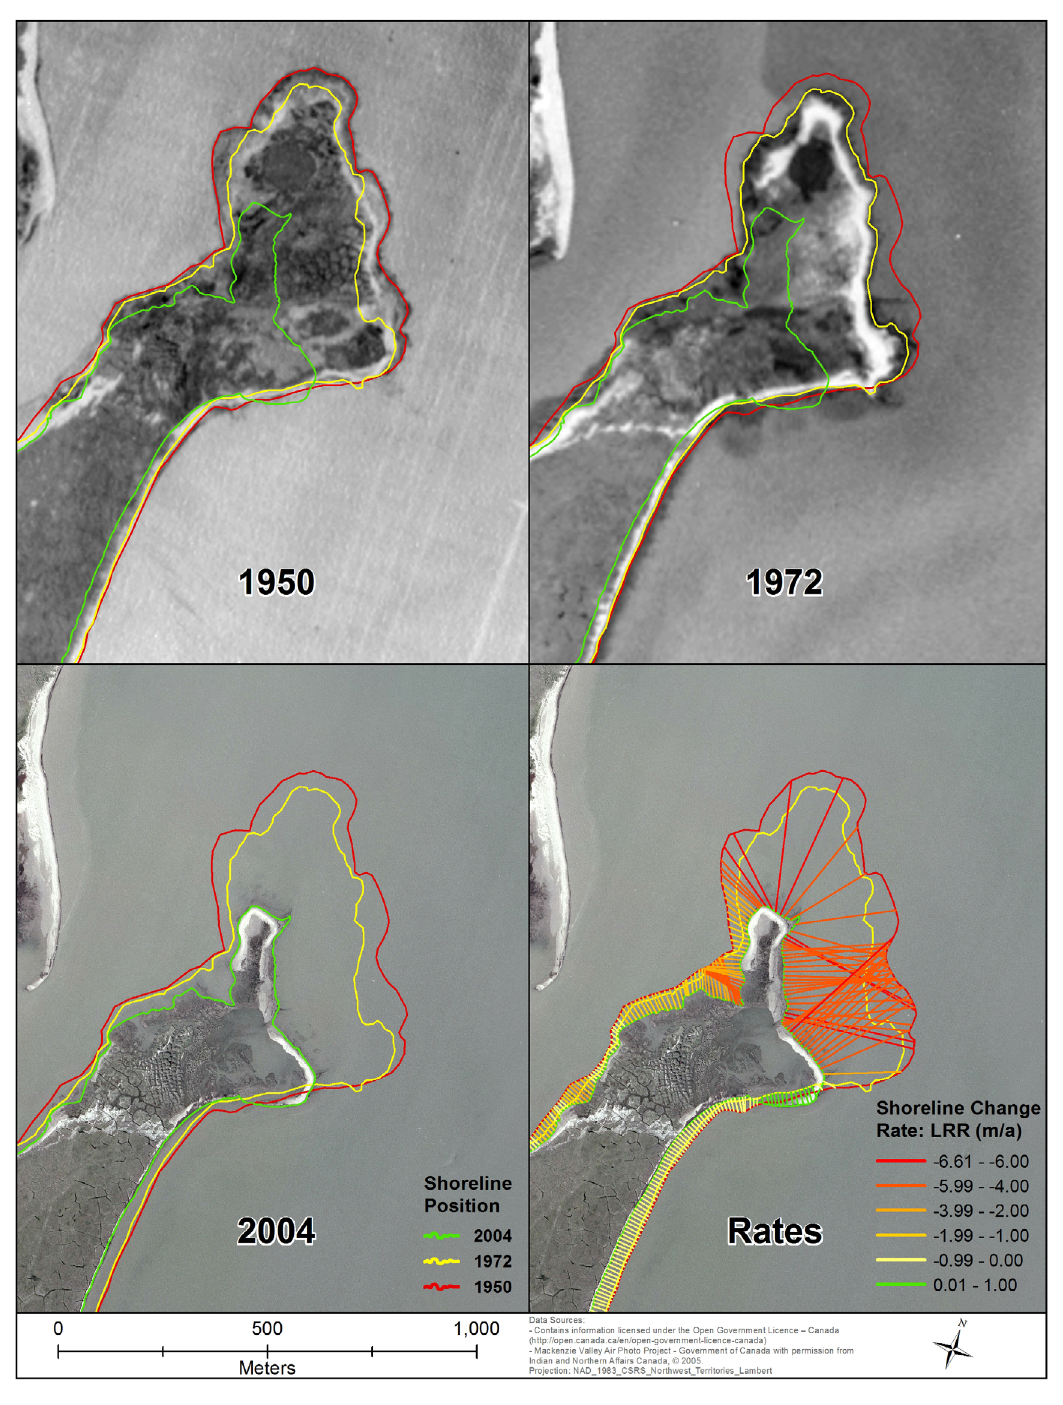
Fig. 2: Shoreline digitization example showing imagery from all three time periods, and related shoreline change